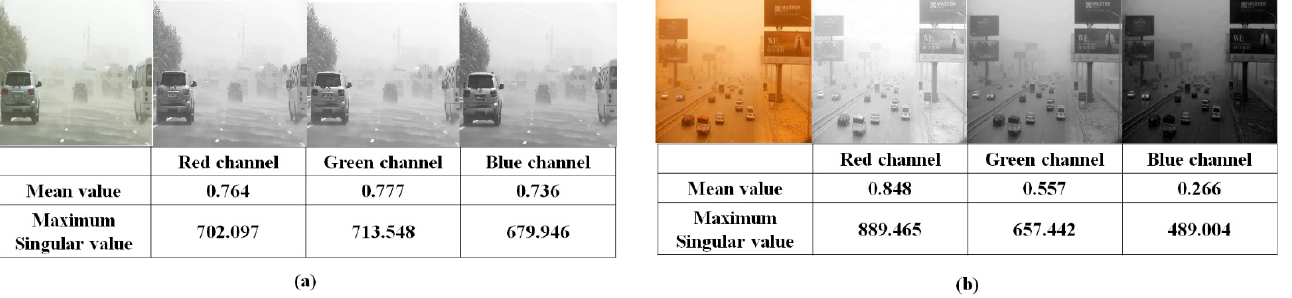
Figure 1. The images’s mean value and their singular values: ( a ) The not degraded duststorm image’s mean value and its singular value on each color channel; ( b ) The degraded duststorm image’s mean value and its singular value.